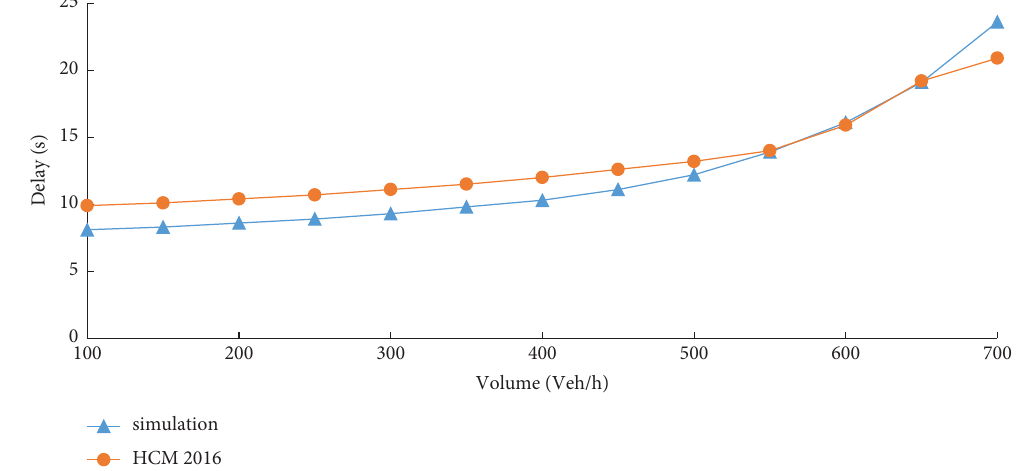
Figure 8: Te efect of volume variations on delay for dual left-turn lane.